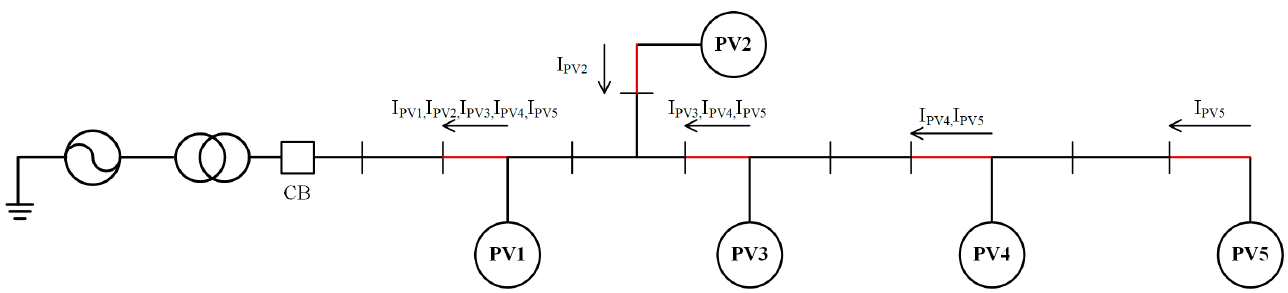
Figure 9. Current supply mode of PV.